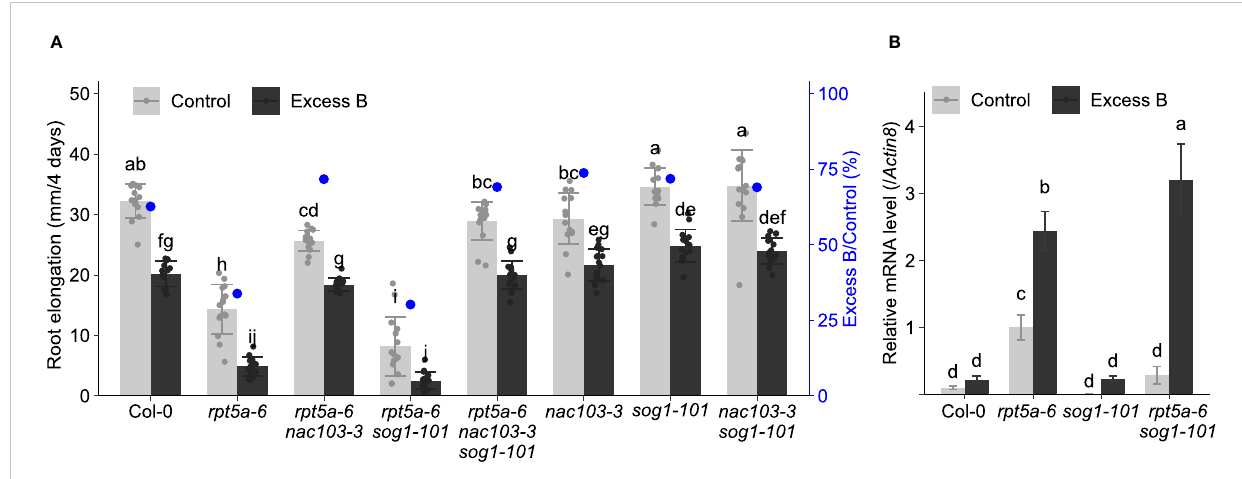
FIGURE 8 Effect of sog1 mutation on excess boron sensitivity in root growth. (A) Root elongation of rpt5a-6, nac103-3, sog1-101 , and their double and triple mutants. Seedlings were precultured in normal conditions (30 µM boric acid) for six days and then transferred to excess boron (3 mM boric acid) or control conditions. Root elongation during four days after the transfer was measured. Values are mean ± standard deviation of 15-16 measurements. Groups sharing the same letters are not signi fi cantly different at p < 0.05 by Tukey-Kramer ’ s test. (B) NAC103 m RNA accumulation in sog1-101 mutant. Plants were grown under the same condition as (A) and mRNA accumulation was quanti fi ed by qRT-PCR. Expression levels were normalized by Actin8 . Values represent mean ± standard deviation of four biological replicates. Groups sharing the same letters are not signi fi cantly different at p < 0.05 by Tukey ’ s